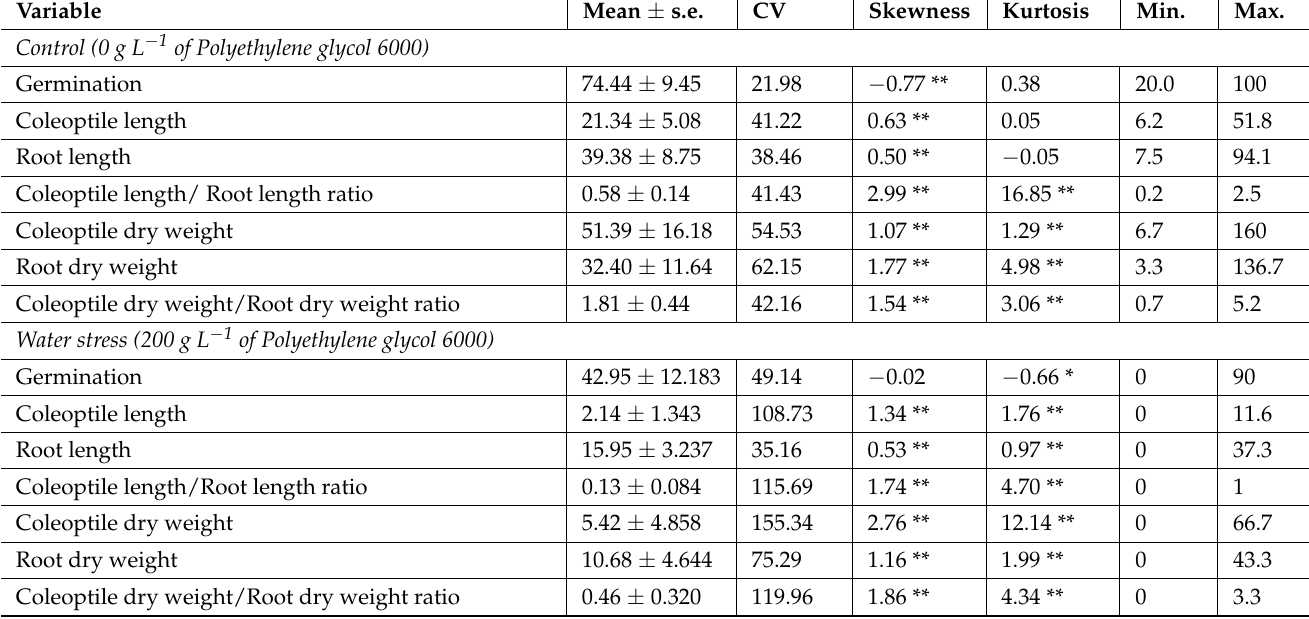
Table 1. Mean ± standard error (s.e.), coefficient of variation (CV), skewness and kurtosis, minimum and maximum of germination and establishment-related traits evaluated under water stress obtained with 200 g L − 1 of Polyethylene glycol 6000 and